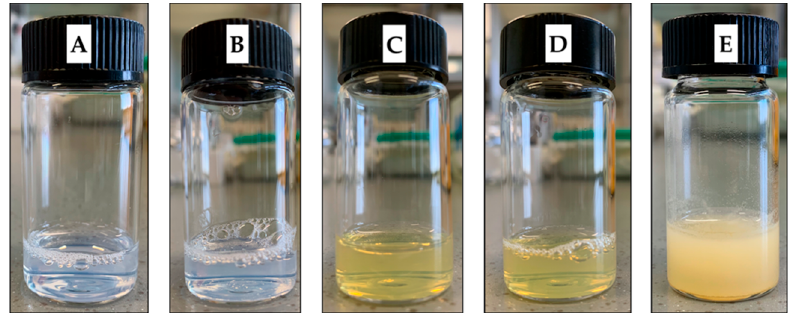
Figure 1. Visual appearance of the nanomicelles. ( A ) Empty polymeric nanomicelles (PNM); ( B ) Empty mixed nanomicelles (MNM); ( C ) Silymarin (SLM)-loaded PNM; ( D ) SLM-loaded MNM; ( E ) SLM aqueous suspension.